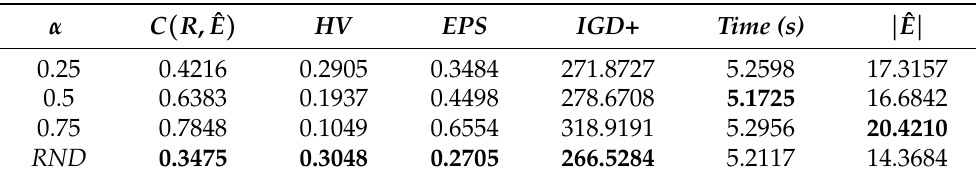
Table 2. Comparison among different α values for the JALEO constructive procedure, without con- sidering the local search procedure.